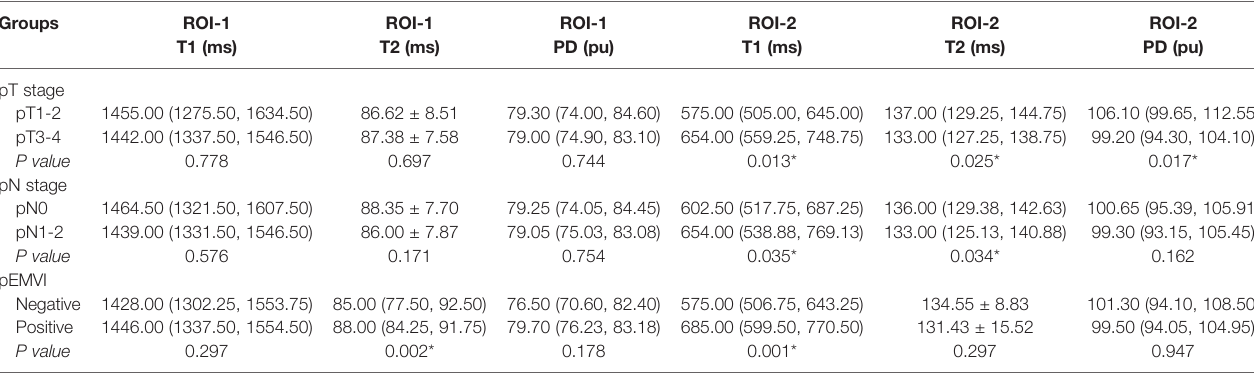
TABLE 3 | The indicators from syMRI for evaluating T, N stage and EMVI of rectal cancer.